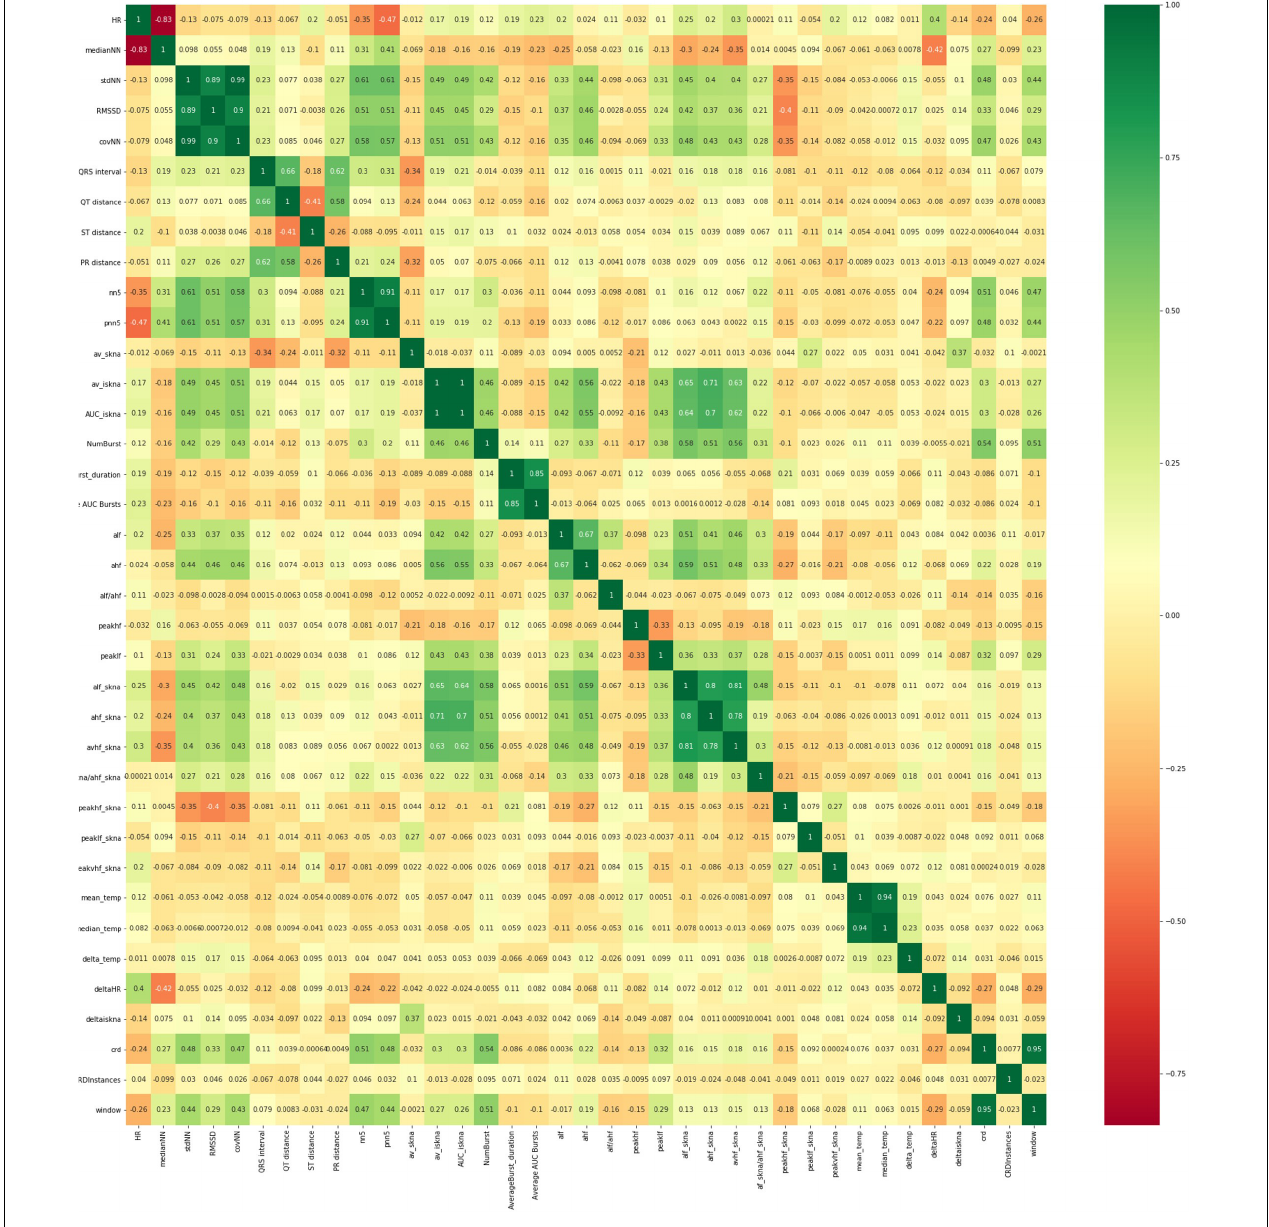
FIGURE 5 | Heatmap of correlation of the thirty-six different features (x and y axes are the features listed in Table 1 above). Highly correlated features are removed and not considered in the development of the